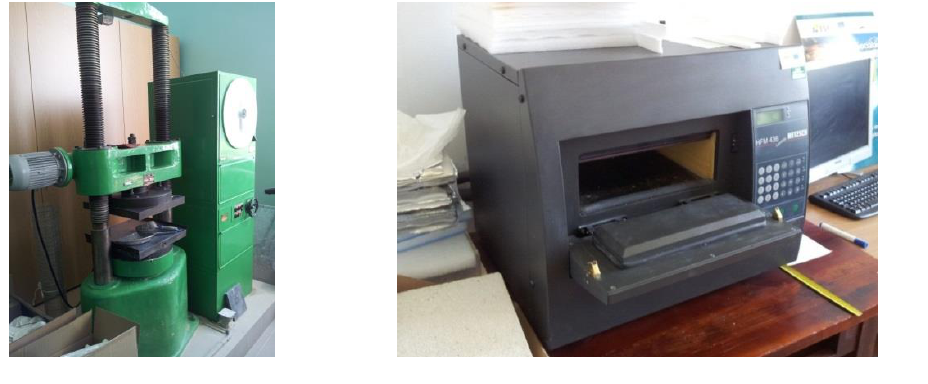
Fig. 4. Heat Flow Meter Netzsch HFM. 436/3/1 E Lambda.